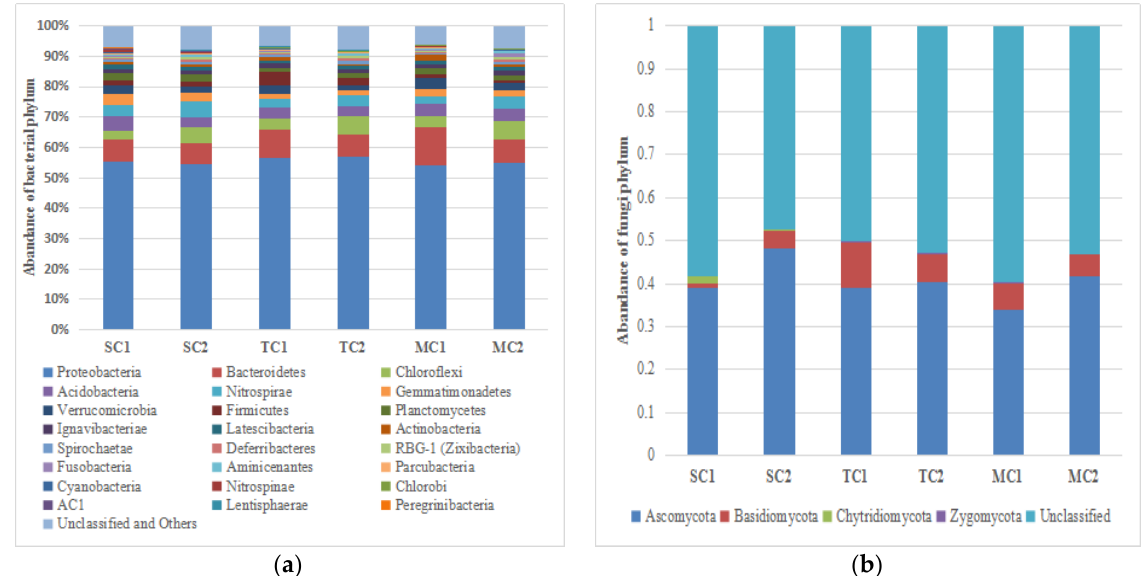
Figure 1. The relative abundance of bacteria ( a ) and fungi ( b ) phylum (% of the total number of reads) in the Spartina alterniflora community (SC), Spartina alterniflora –mangrove mixed community (TC), and the mangrove community (MC) samples, where 1 represents the 0–15 cm soil layer and 2 represents the 15–30 cm soil layer.